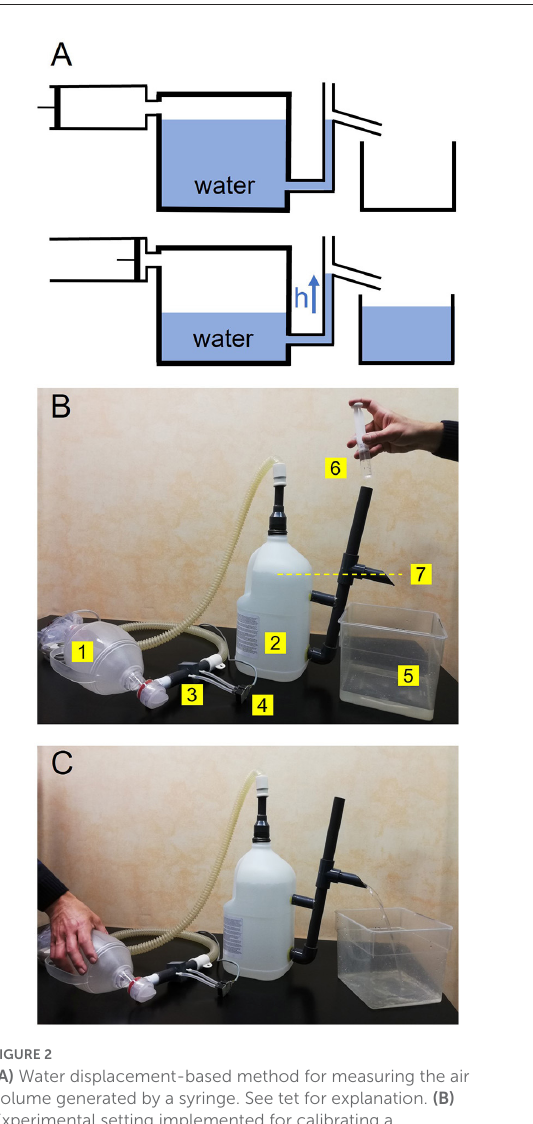
FIGURE2 (A) Water displacement-based method for measuring the air volume generated by a syringe. See tet for explanation. (B) Experimental setting implemented for calibrating a pneumotachograph from two-maneuver volumes assessed by water displacement. The air when compressing a resuscitation bag (1) is introduced into the chamber (2) through the pneumotachograph to be calibrated (3) connected to a differential pressure transducer (4). The water to be displaced from the chamber is collected by a recipient (5). Before starting the maneuver, the chamber is carefully filled with water (6) until achieving the level of the outlet (7), as indicated by the yellow line. (C) During the maneuver, an operator is compressing the resuscitation bag and the displaced water is collected by the recipient to measure the total maneuver volume. The pneumotachograph calibration parameters (K 1 and K 2 ) are computed by combining the pressure signals recorded and the volumes in two different maneuvers (Supplementary